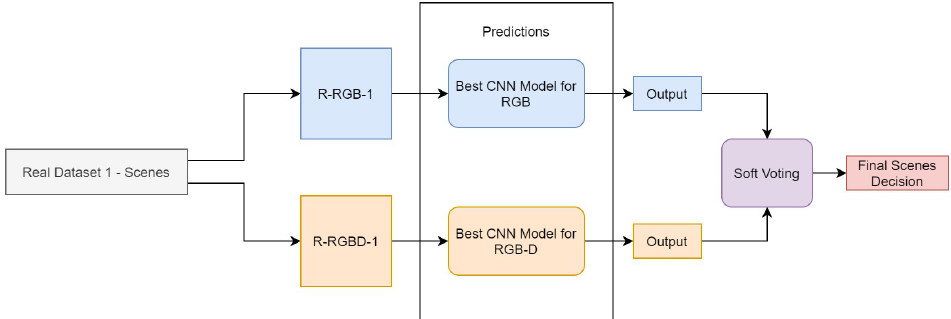
Figure 19. Blending CNN pipelines approach.